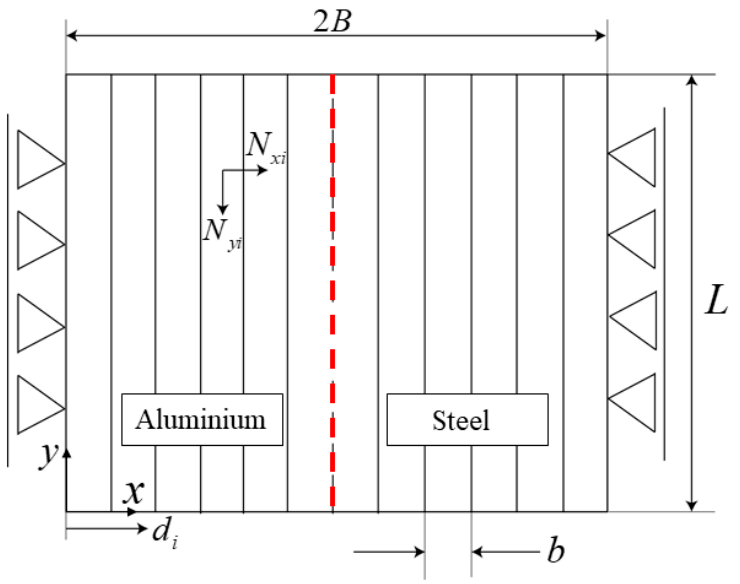
8 of 20 Figure 7 . Schematic representation of the welded plates with lateral and out-of-plane constraints (uniformly applied to the top and bottom surfaces of the plates) assumed in the FE model. 4.2. Analytical Model With reference to Figure 8, in order to write the equations that govern the problem in matrix form (constitutive, equilibrium, and compatibility equations), the welded plates were divided into a discrete number ( n ) of bars. For the sake of simplicity, all bars had the same width ( b ), while n was chosen sufficiently high to account for the temperature gra- dient near the weld line with a good approximation. It was assumed that at each time step the temperature of each bar was uniform, depending only on its x coordinate (i.e., T = T (x, t )). In other words, the temperature gradient in the y direction was neglected, a hy-